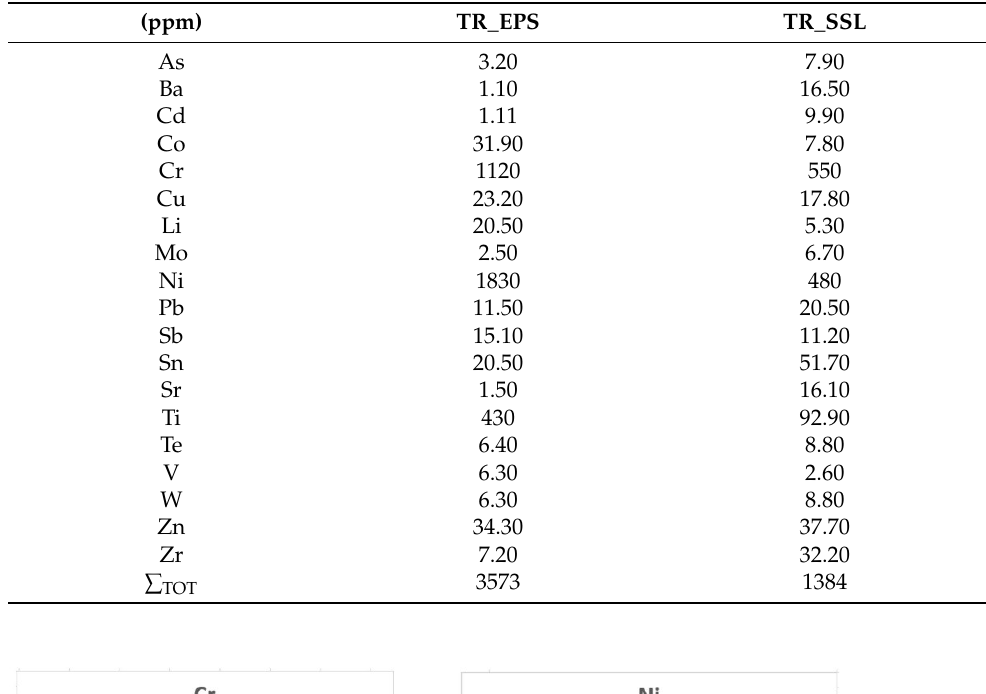
Table 2. Trace element concentrations (ppm) in the studied tremolite asbestos from Episcopia